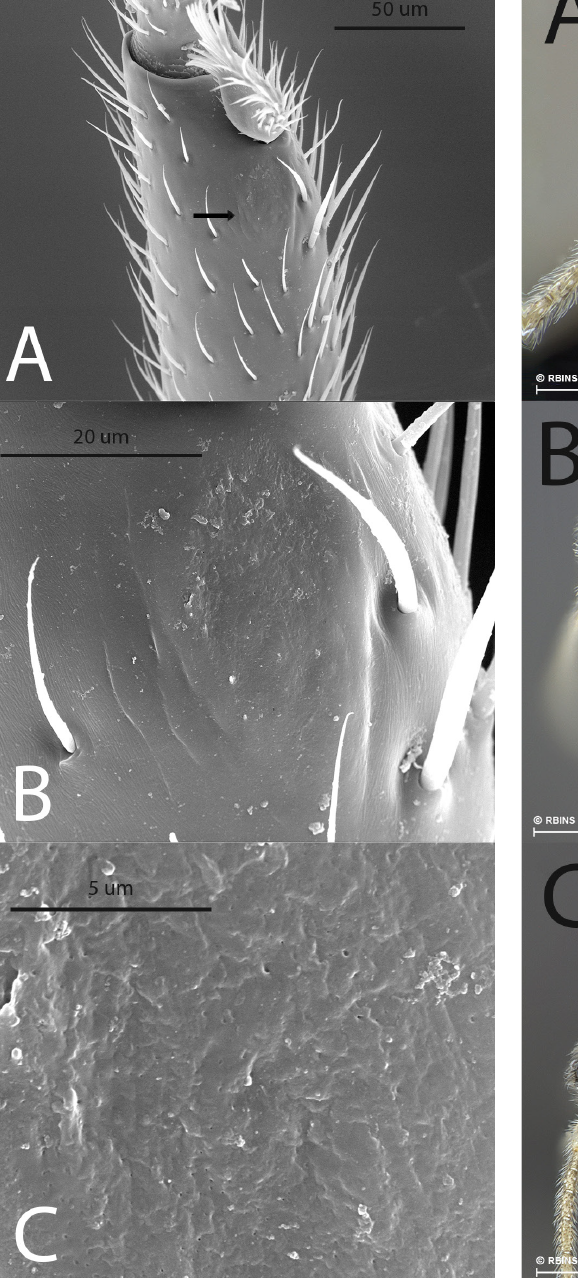
Fig. 8. Leptanilloides ‘Male 4’ (specimen code 4870101) from southern Ecuador. A . Head in full face view. B . Habitus in dorsal view. C . Habitus in lateral